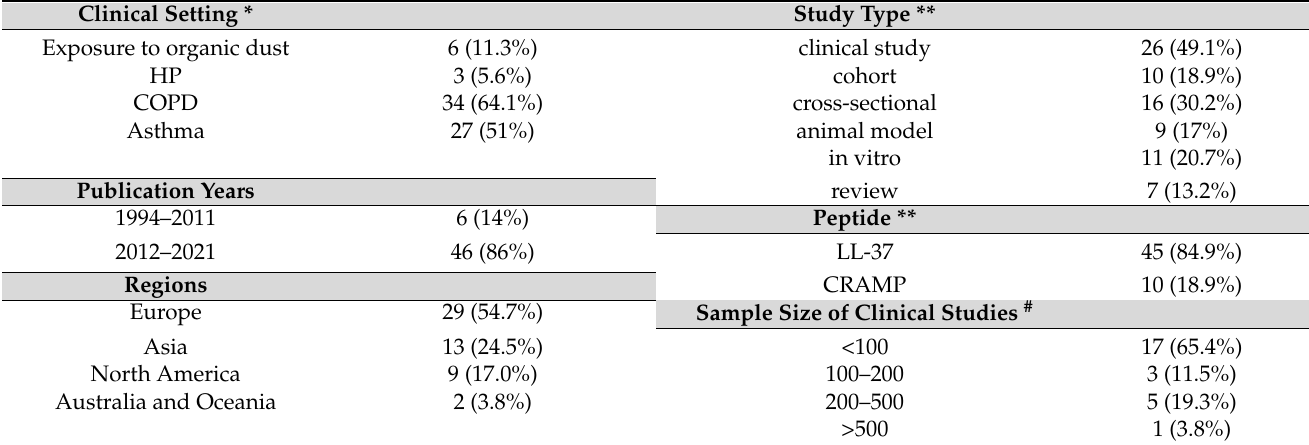
Figure 2. Annual distribution of published articles included in the qualitative analysis (n = 53). In vitro studies and animal models accounted for 20% (n = 11) and 17% (n = 9) of studies respectively, with seven articles representing reviews (13%). The majority of included articles originated from Europe (n = 29, 54%), followed by Asia (n = 13, 24%) and North America (n = 9, 17%). Table 1 shows the detailed characteristics of studies included in this scoping review. Table 1. Characteristics of studies included in the scoping review (n =